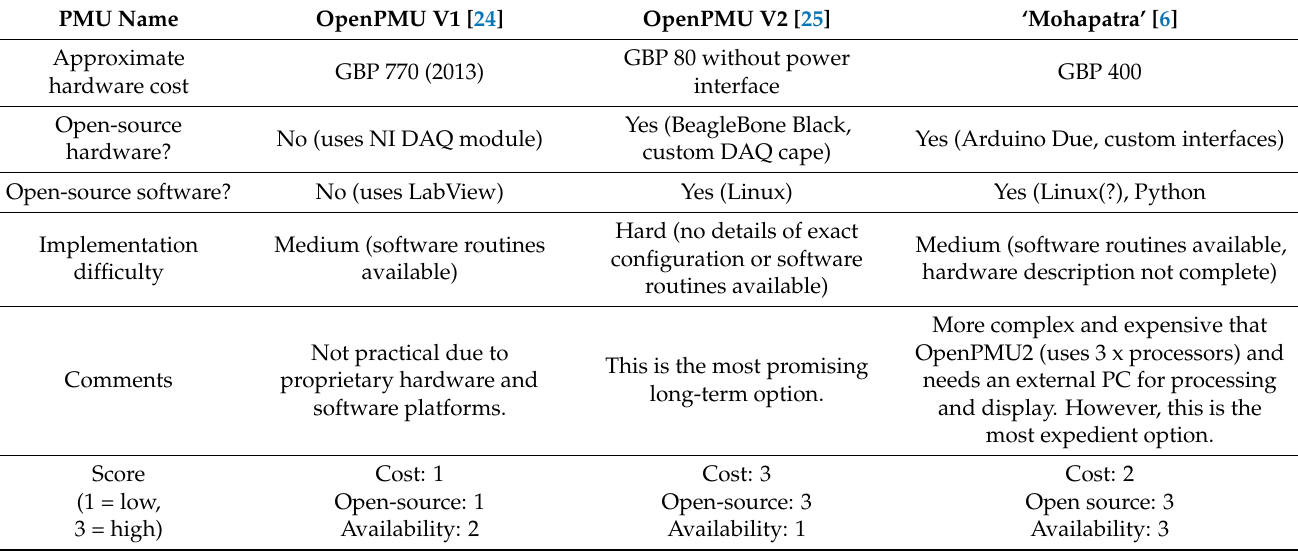
Table 1. Comparative results among low-cost PMUs.